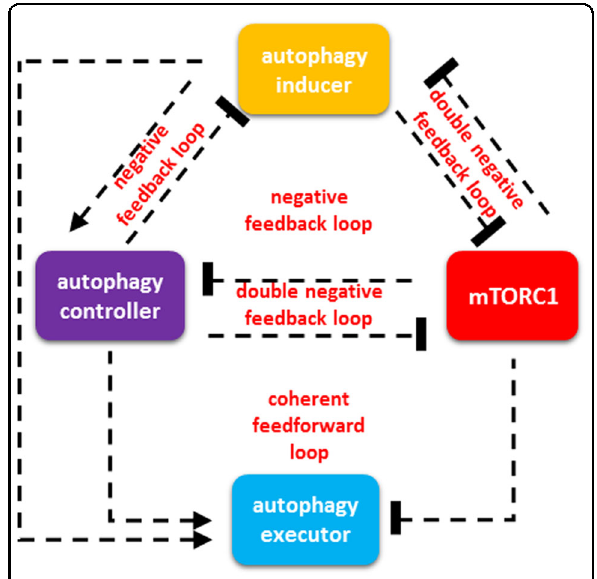
Fig. 1 The comprehensive wiring diagram of autophagy induction upon cellular stress. A general wiring diagram to describe the precise mechanism of autophagy induction. The regulatory elements and their connections of life-and-death decision when the autophagy inducers (AUIN), the autophagy controllers (AUCO), the autophagy executors (AUEX) and the elements of mTORC1 pathway are grouped together in isolated orange, purple, blue and red boxes, respectively. Dashed lines show how the molecules can in fl uence each other. Blocked end lines denote